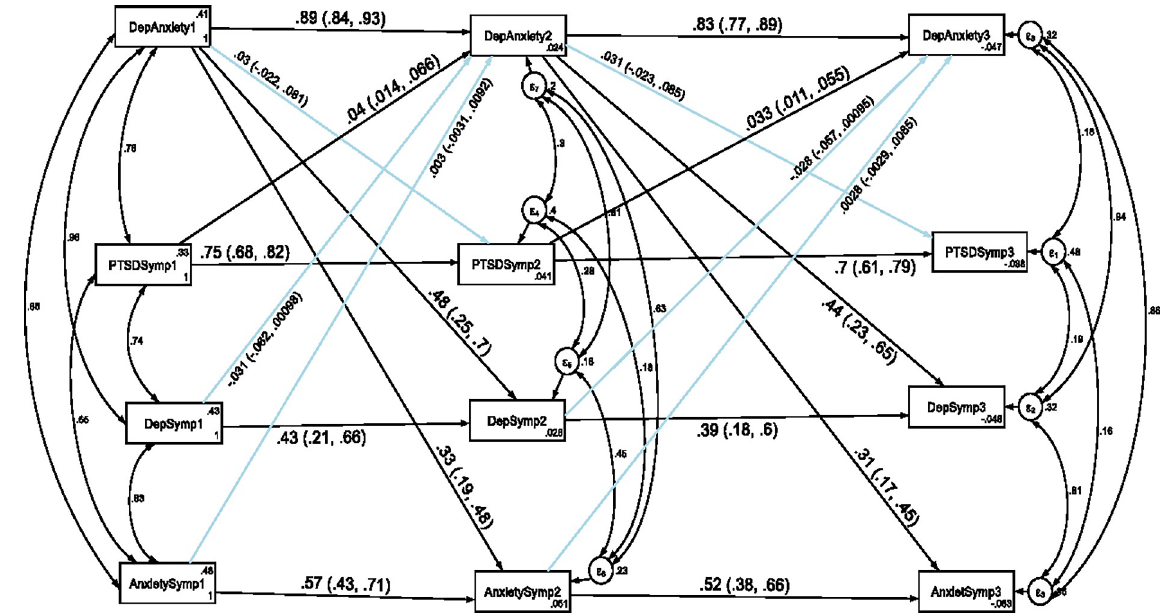
Fig 2. Longitudinal stability and cross-lagged association of depression, anxiety and PTSD with comorbidity of depression and anxiety. Note : All β ’s are standardized estimates with 95%